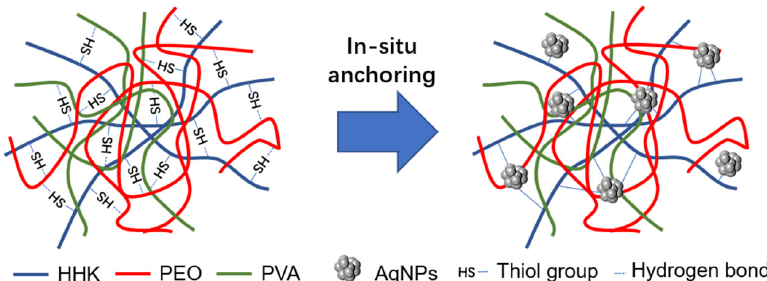
Figure 1. Schematic illustration of in situ